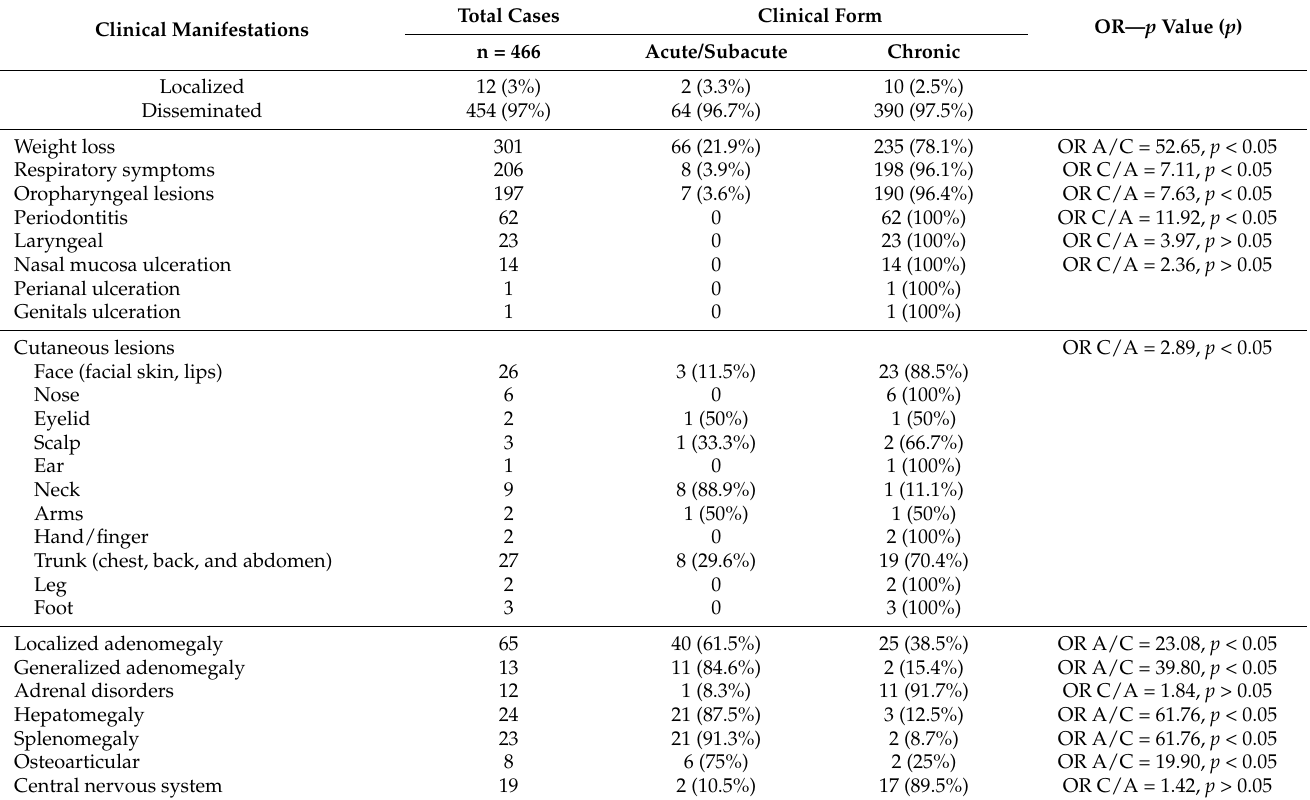
Table 5. Main clinical manifestations according to clinical form of 466 patients recorded during